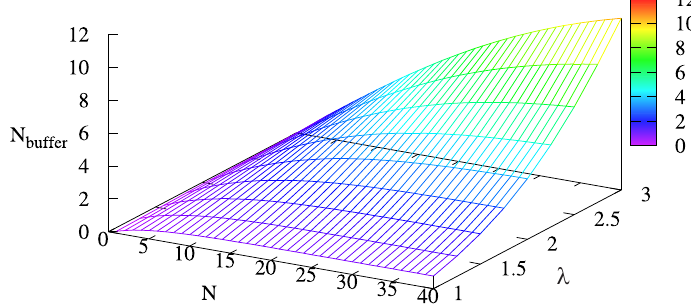
Figure 2. Dependence of N buf fer on N and λ .